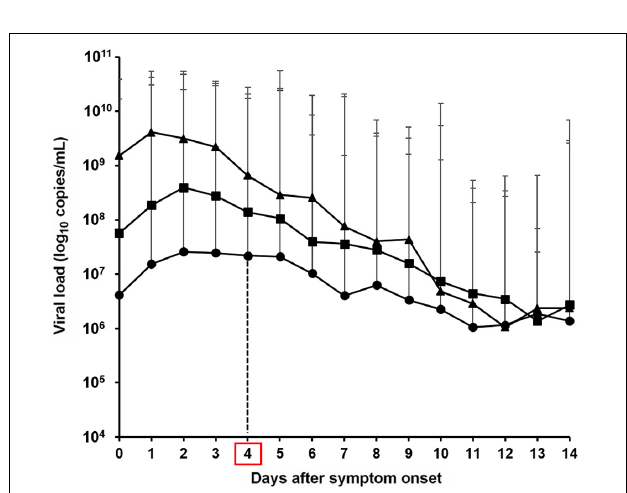
FIGURE 1 | Average cycle threshold (Ct) value of SARS-CoV-2 for each wave on 0–4, 5–9, and 10–14 days following symptom onset [black; first wave, blue: second and third waves, red; fourth wave (delta variant), * p -value < 0.05, Anova and generalized linear model were used to examine differences in the Ct values for each